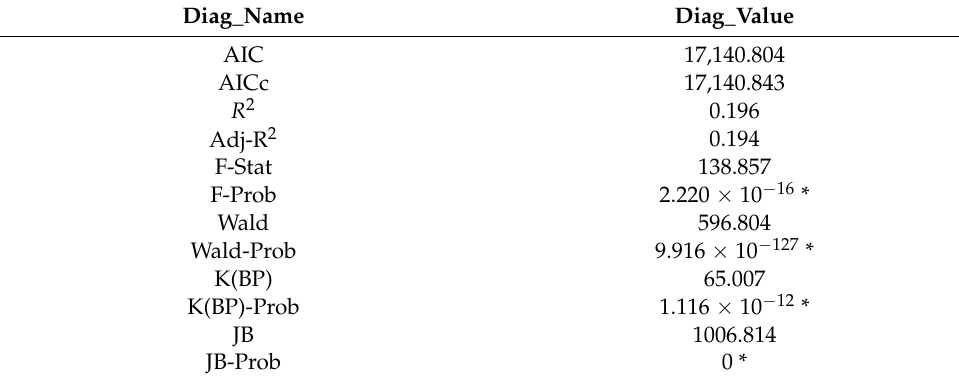
Table 6. Summary diagnostics of the OLS model with the five explanatory variables (HOUSE- HOLD_SIZE, PER_INTERNET, COVID_R, BACHELOR,